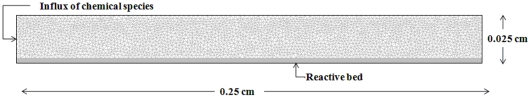
Representation of the quadrilateral boundary layer mesh used for computational modeling of the parallel flow chamber near the region representing the fluid/solid interface.In this example 6776 mesh elements are used with 2500 in the boundary layer. This mesh application improves computational representations of momentum and mass transfer gradients in the boundary layers.